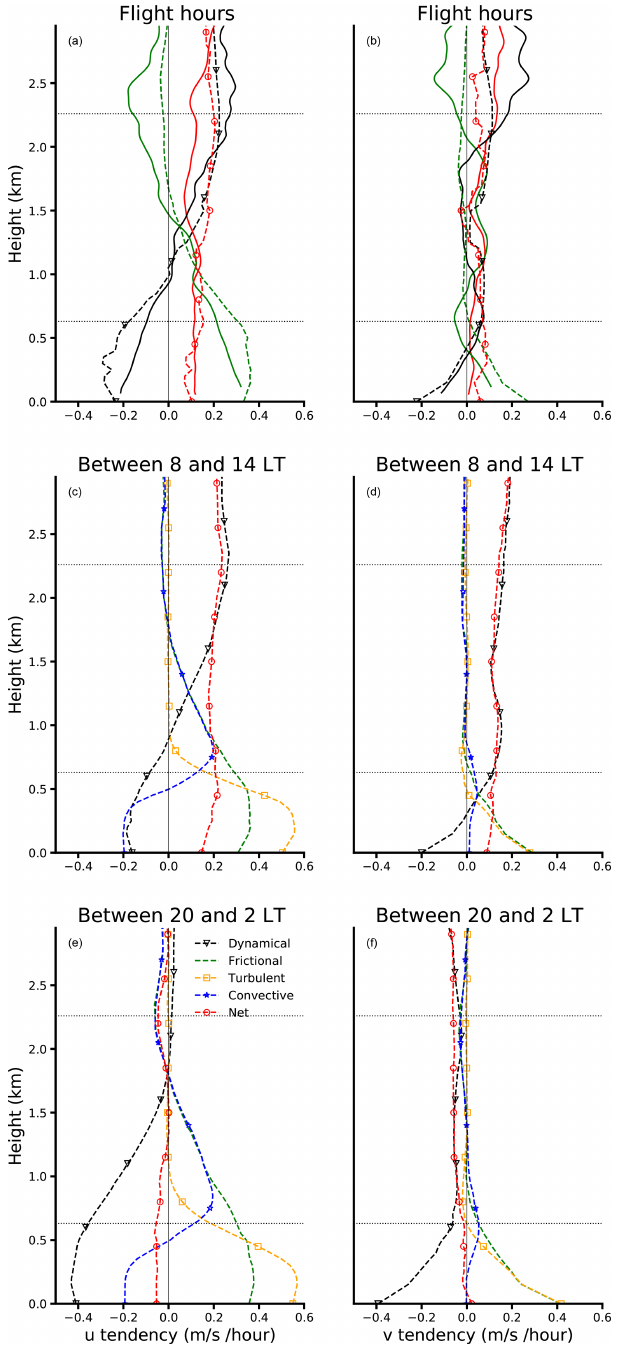
Figure 13. Components of the momentum budget retrieved from the dropsondes (solid) and the forecast (dashed). The net tendency (red circles) balances the dynamical force (black triangles) and the frictional force (green). The latter is split into turbulent and convec- tive for the forecast. The top row (a, b) refers to days and hours sam- pled by the dropsondes (flight hours). The middle row (c, d) refers to the hours between 08:00 and 14:00LT during all EUREC 4 A days. The bottom row (e, f) refers to the hours 20:00 to 02:00LT during all EUREC 4 A